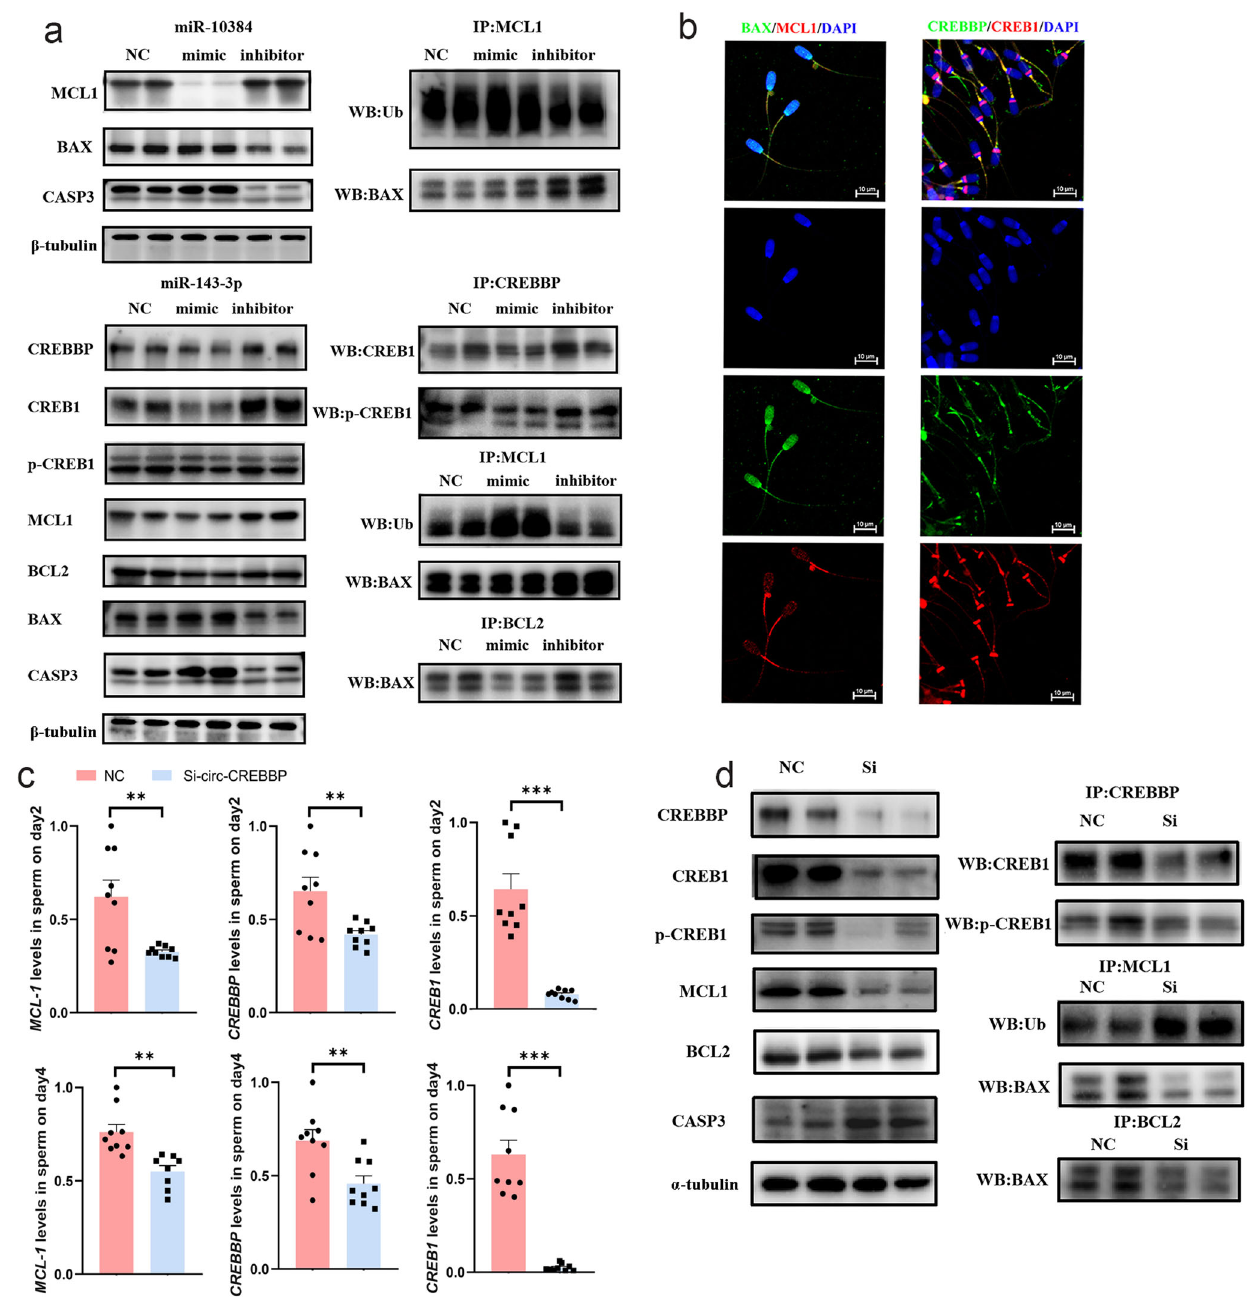
Fig. 7 Circ-CREBBP maintains the survival of sperm via the PI3K/Akt pathway. a Western blot assays were used to evaluate the total protein levels of PI3K/Akt and apoptosis pathway members MCL1, CREBBP, CREB1, BCL2, BAX, and CASP3, the ubiquitination level of MCL1 and the phosphorylation levels of CREB1 in sperm incubated with EV, EV-miR-10384/EV-miR-143-3p mimic, and EV-miR-10384/EV-miR-143-3p inhibitor. b Immuno fl uorescence data showed that MCL1 and BAX and CREBBP and CREB1 were mainly colocalized in sperm tails. c The mRNA expression of MCL1 , CREBBP and CREB1 in sperm incubated with EV (NC) or Si-circ-CREBBP was detected by qPCR. Data are presented as the mean ± SEM. * P ≤ 0.05, ** P ≤ 0.01, *** P ≤ 0.001 (Student ’ s t test), n = 3 for each group. d Western blot assays were used to detect the protein levels of PI3K/Akt and apoptosis pathway members MCL1, CREBBP, CREB1, BCL2, BAX, and CASP3, the phosphorylation levels of CREB1 and the ubiquitination level of MCL1 in sperm incubated with EV (NC) or EV-Si-circ-